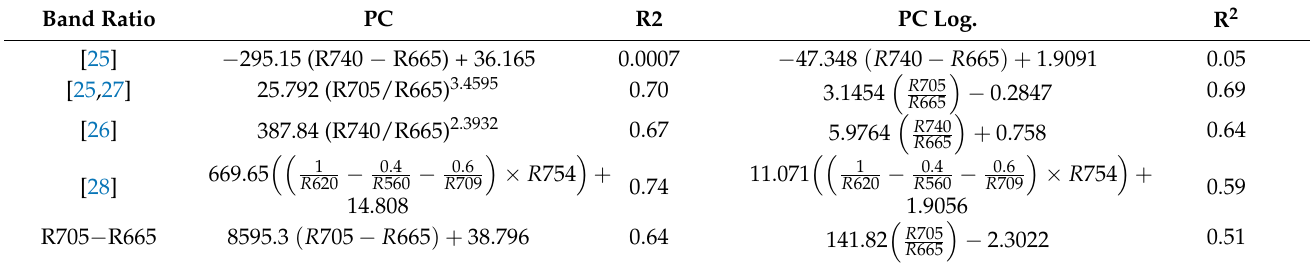
Table 5. Calibration results: fit equations and coefficients of